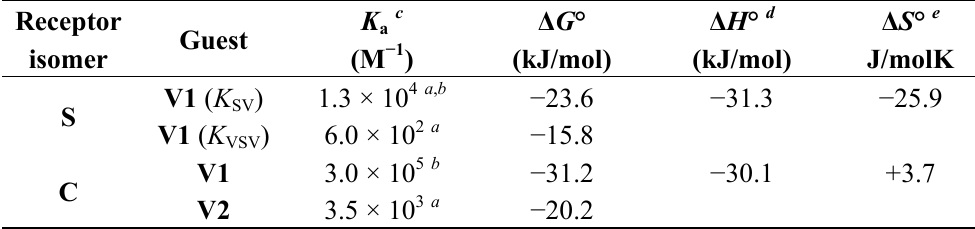
Table 3. Association constants ( K ) and binding free energies ( Δ G °) at 298 K and the a enthalpic ( Δ H °) and entropic ( Δ S °) contribution to the binding free energy between isomers C and S and viologen